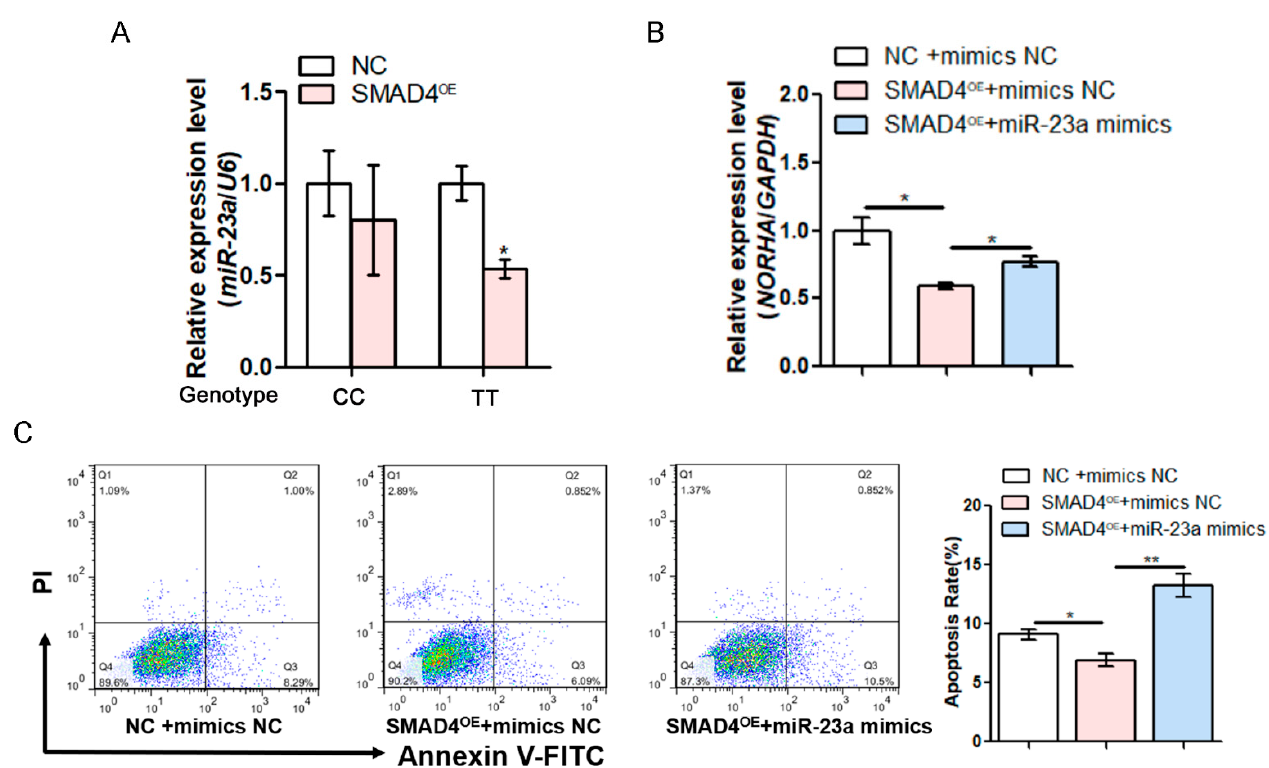
Figure 5. SMAD4 inhibits the expression and function of miR-23a. ( A ) After transfection with pcDNA3.1-SMAD4, miR-23a levels were detected in pGCs with genotypes CC and TT for the SNV g. − 398C>T. ( B , C ) NORHA levels ( B ) and the apoptosis rate ( C ) in pGCs after co-transfection with pcDNA3.1-SMAD4 and miR-23a mimics at 48 h. Data are expressed as the mean ± S.E.M., and significance was tested using a t -test ( A ) and a one-way ANOVA ( B , C ) (ns, not significant, * p < 0.05, ** p < 0.01).